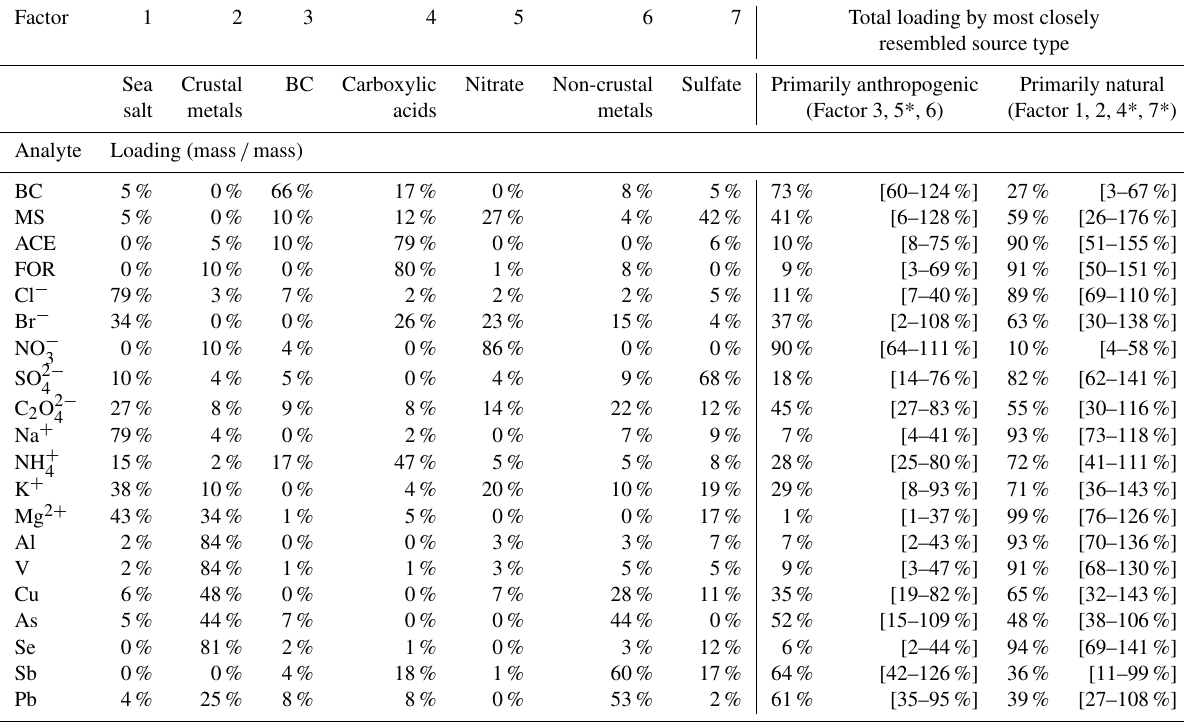
Table 3. Overview of analyte